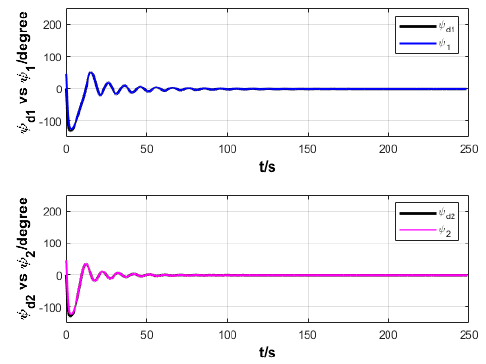
Figure 8. Heading angle of USV under two strategies.